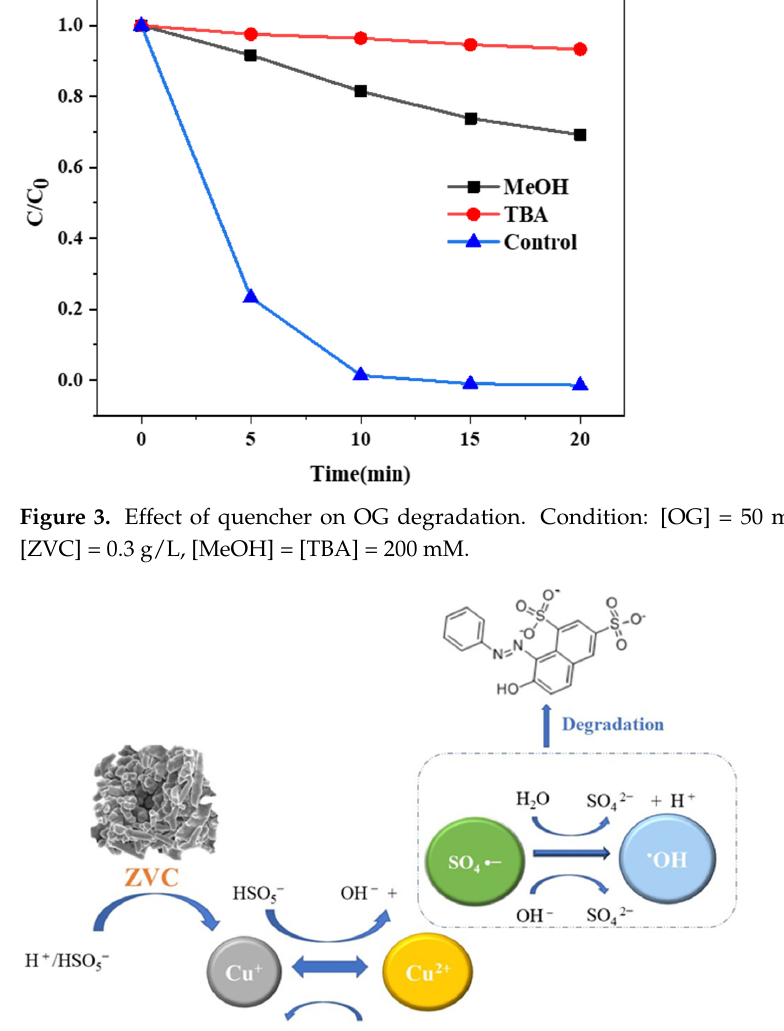
Figure 4. Possible reaction mechanism of ZVC/PMS system for OG degradation.